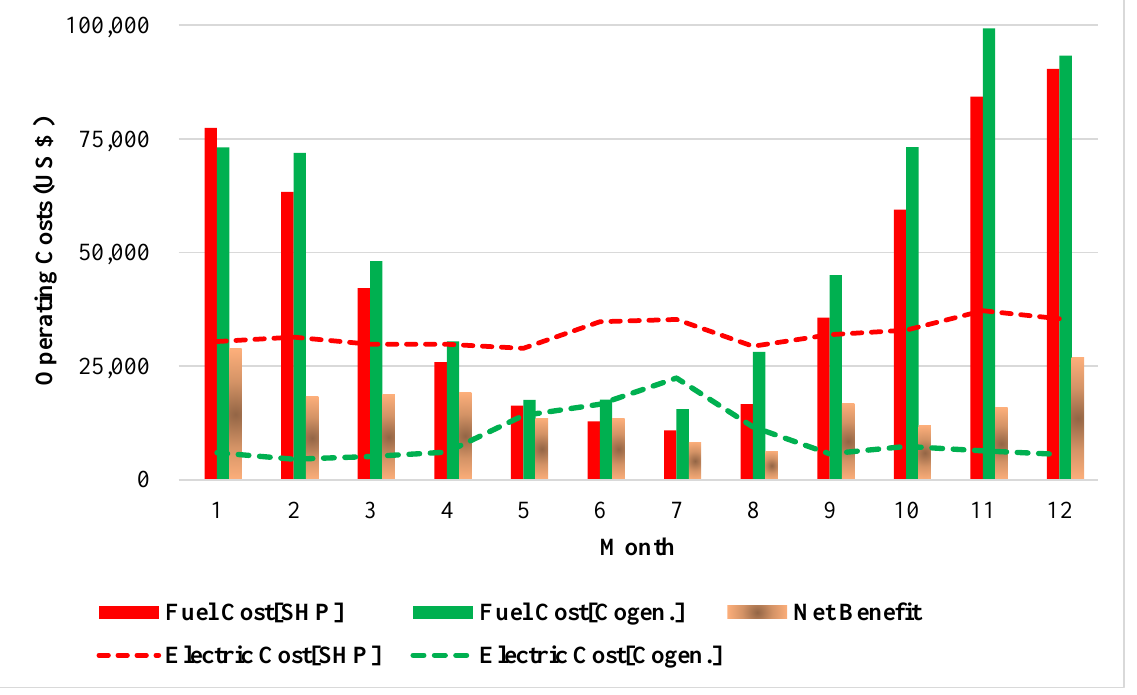
Figure 5. Comparison of the monthly operating cost and net benefits before and after the installation of the cogeneration system.